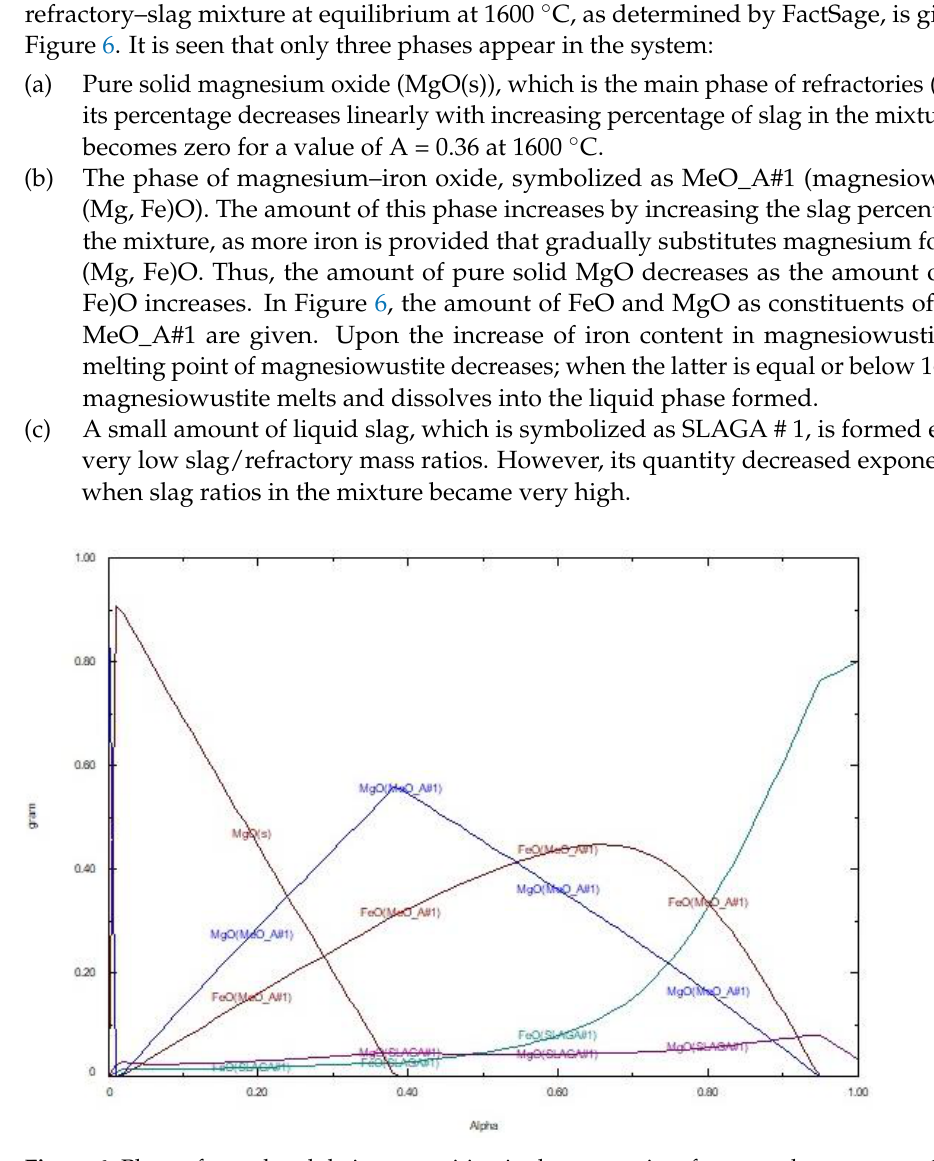
Figure 6. Phases formed and their composition in the magnesia refractory–slag system at 1600 ◦ C determined by FactSage vs. their mixing ratio (A = 0 refractory no slag, A = 1 pure slag).